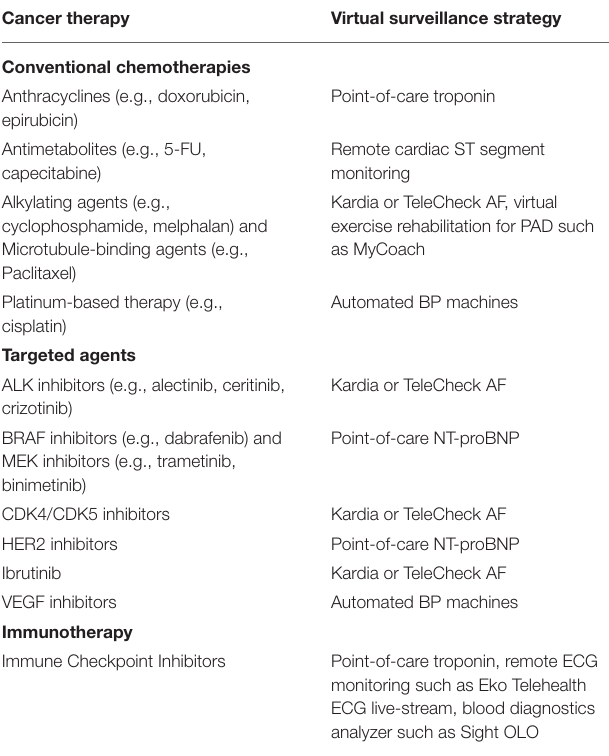
TABLE 1 | Potential strategies for virtual surveillance based on cancer